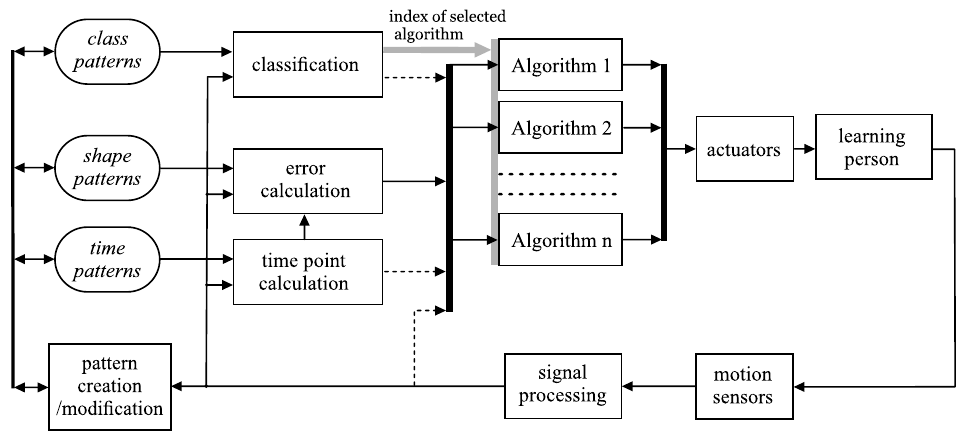
Figure 2. General flowchart of the real-time teaching system prototype. The signal that selects the teaching algorithm is symbolized by the thick gray